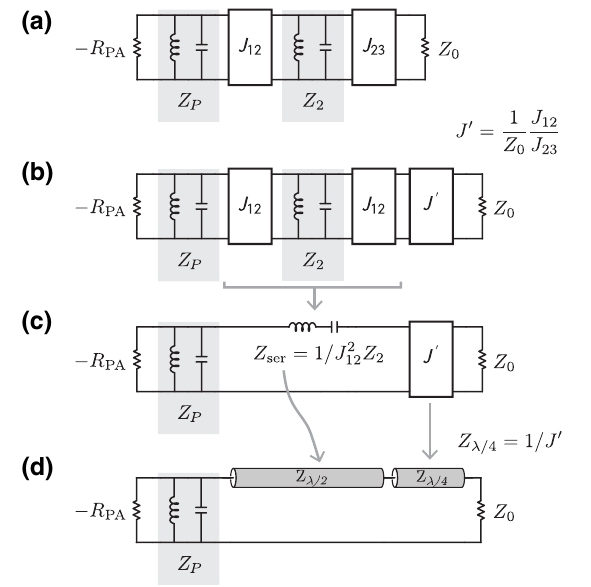
FIG. 21. Transformation used to go from shunt coupled res- onators to ladder configuration with series auxiliary mode (a, b, c), and finally to the transmission-line topology of Ref. [6] (d). The pumped junction is represented by a negative resistance − R PA